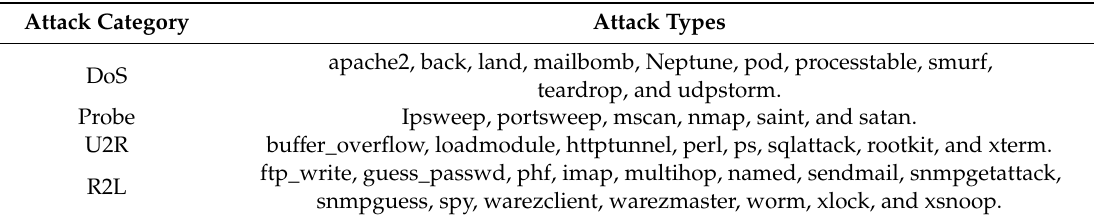
Table 1. The types of attacks contained in each category.